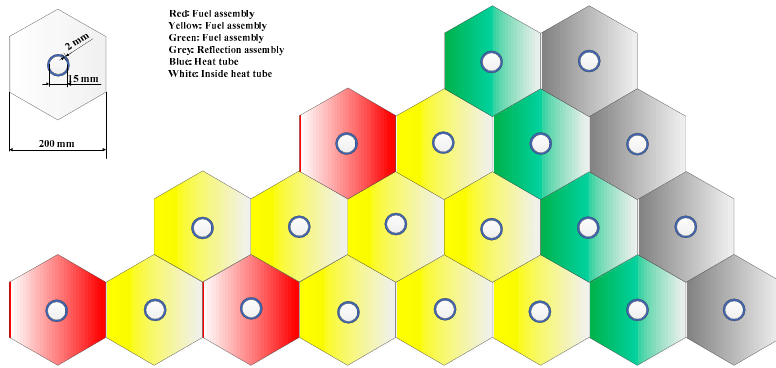
Figure 13. Heat pipe cooled reactor for nuclear thermal propulsion. Table 9. Parameters of the heat pipe cooled reactor for nuclear thermal propulsion.